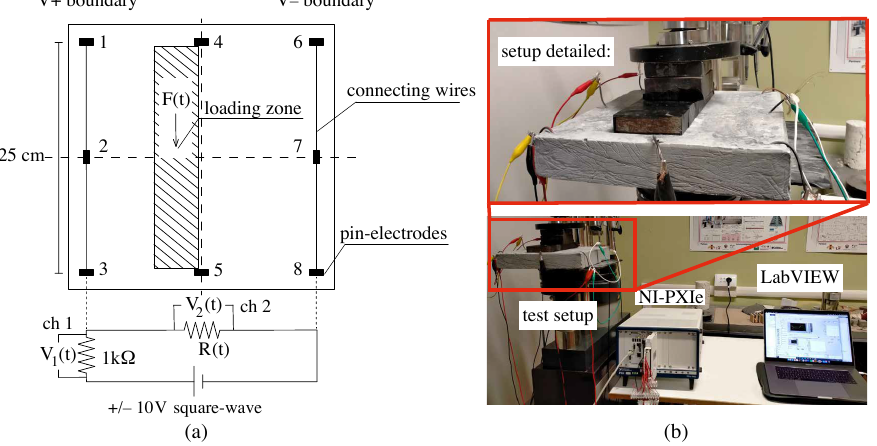
Figure 7. The test setup created for lab sample; ( a ) load placement, and equivalent electric circuit; ( b ) picture of experimental setup and